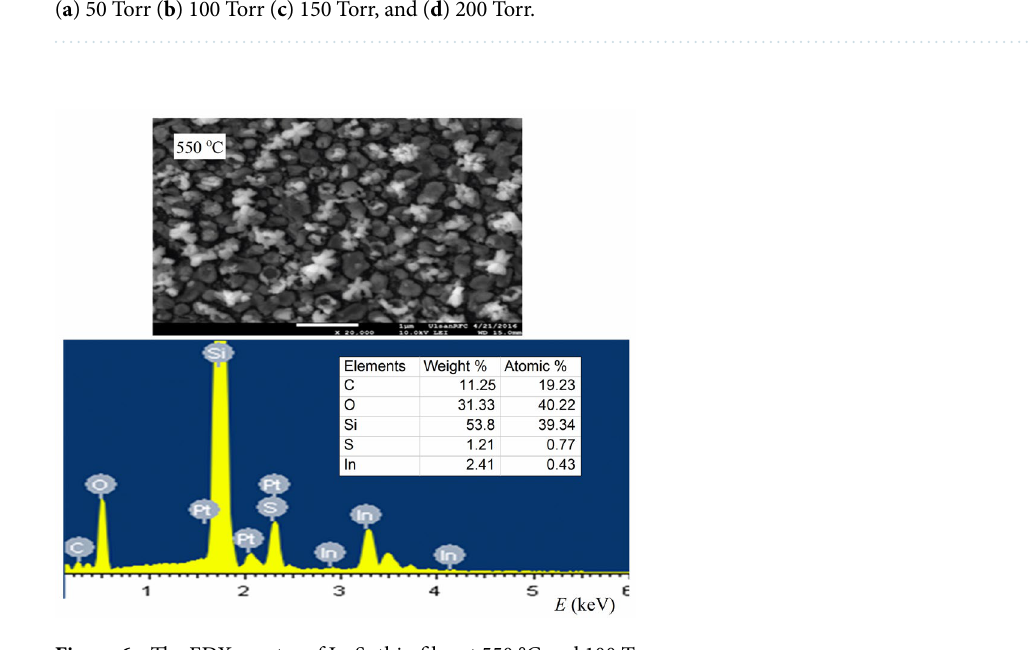
Figure 5. ( a – d ): The SEM images of the grown thin film of In 2 S 3 at temperature 550 °C with different pressures ( a ) 50 Torr ( b ) 100 Torr ( c ) 150 Torr, and ( d ) 200 Torr.